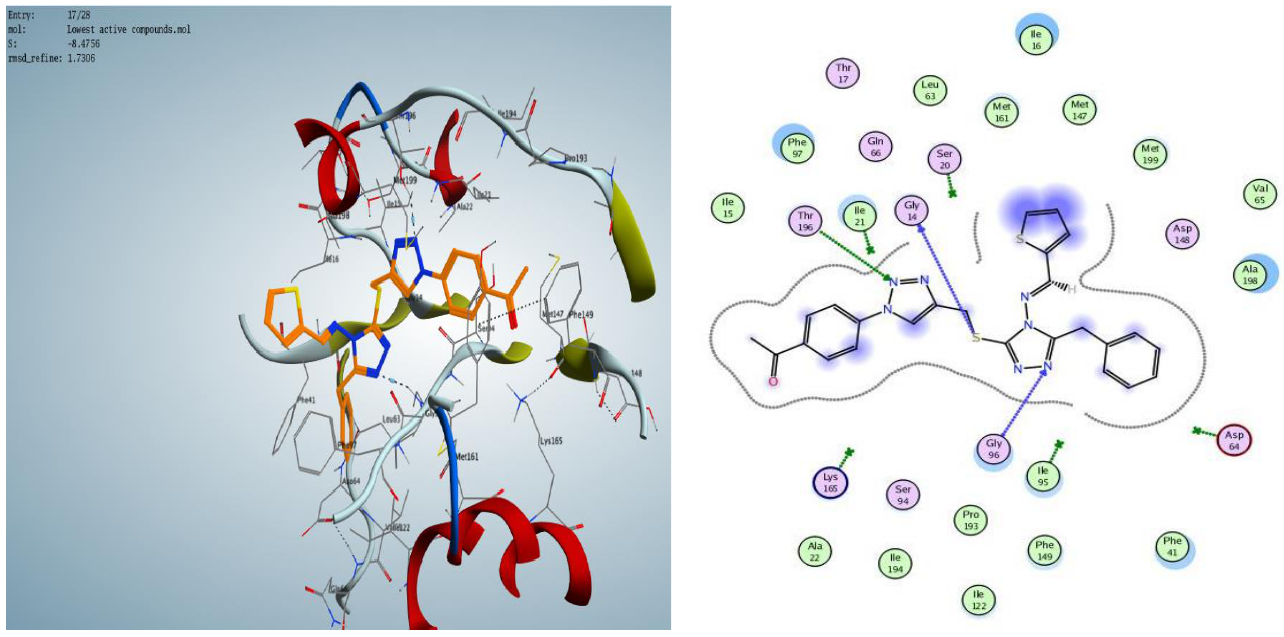
Figure 14. Docking and binding pattern of Rifampicin into inhA active site (PDB ID: 4TRO) in 2D (right panel) and 3D (left panel).